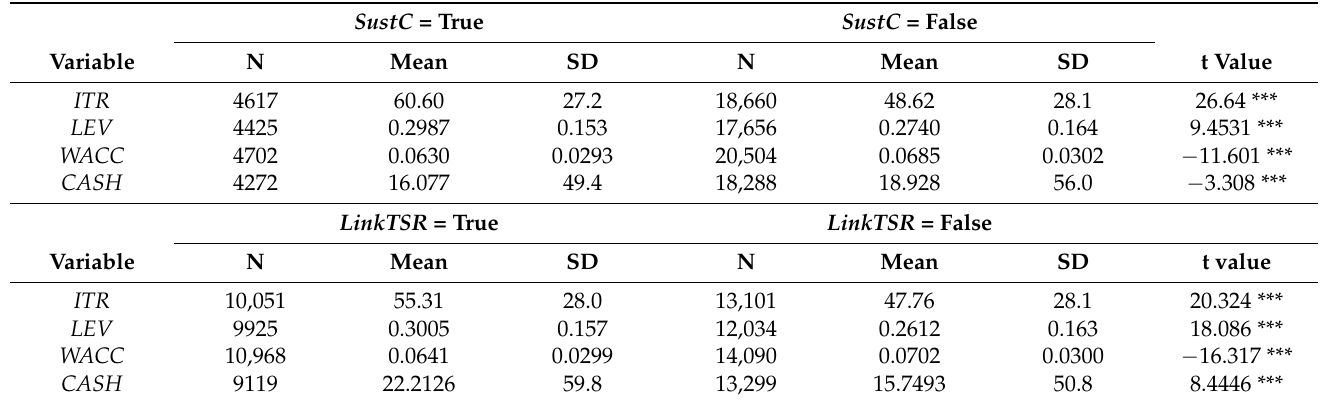
Table 12. Independent samples t tests for the classification according to SustC and LinkTSR . SustC = True SustC =